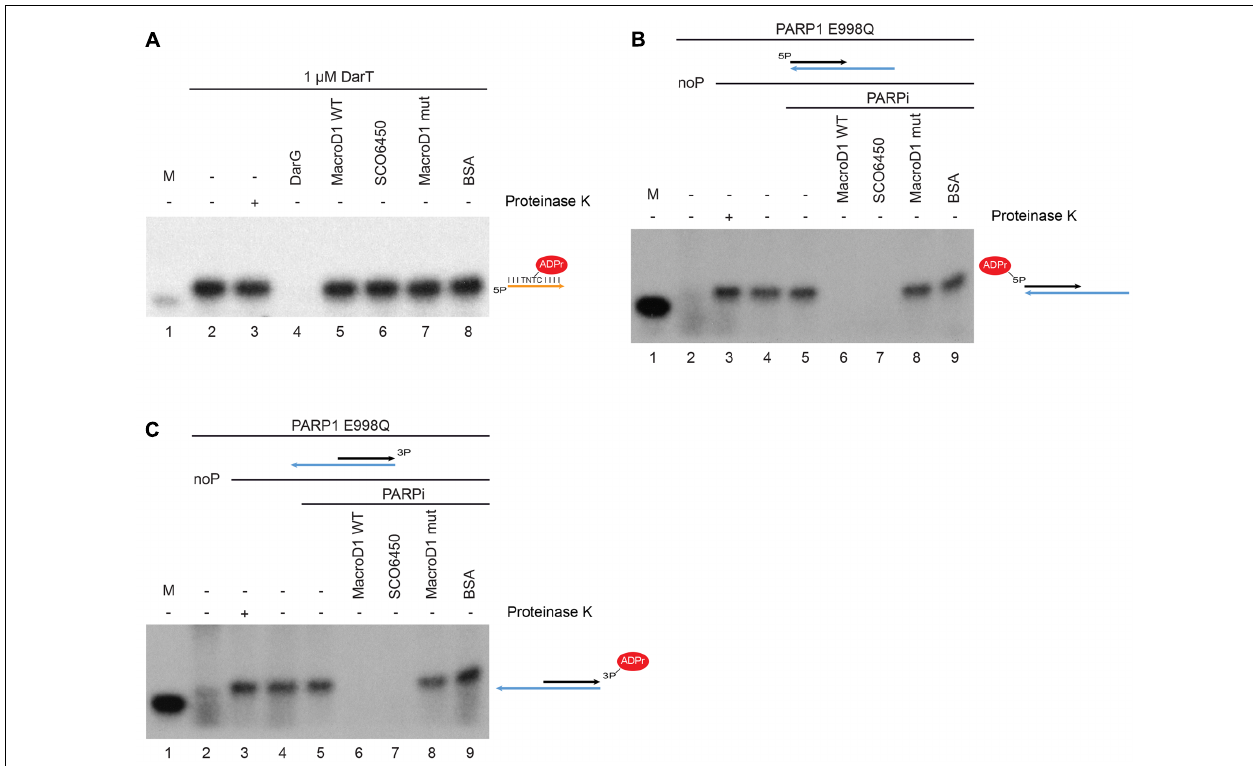
FIGURE 4 | MacroD1 and Streptomyces coelicolor protein SCO6450 efficiently remove mono-ADP-ribose adducts from ADP-ribosylated phosphorylated double stranded DNA ends. (A) De-ADP-ribosylation of ADP-ribosylated thymidine base on single stranded DNA by DarG (lane 4), MacroD1 WT (lane 5), SCO6450 (lane 6), and MacroD1 mutant (MacroD1 G270E – lane 7) macrodomain-containing proteins. Thymidine base on single stranded DNA was ADP-ribosylated by DarT (lanes 2–8). In both (B,C) phosphorylated (lanes 3–9) double stranded DNA was mono-ADP-ribosylated by PARP1 E998Q. Removal of mono-ADP-ribosylated 5 (cid:48) (B) and 3 (cid:48) (C) phosphorylated double stranded DNA ends by MacroD1 WT (lane 6), SCO6450 (lane 7), and MacroD1 mutant (MacroD1 G270E – lane 8) macrodomain containing protein; ddH 2 O (lane 5) and BSA (lane 9) were used as negative controls. PARP1 E998Q was unable to ADP-ribosylate non-phosphorylated double stranded DNA (noP) (lane 2). Mono-ADP-ribosylated phosphorylated double-stranded DNA samples were treated with (lane 3) or without PK (lane 4) to confirm DNA and not protein was the substrate of PARP1 E998Q modification. 32 P radiolabelled 21mer DNA was used as a size marker (M, lane 1 in all experiments). PARPi, PARP inhibitor; BSA, bovine serum